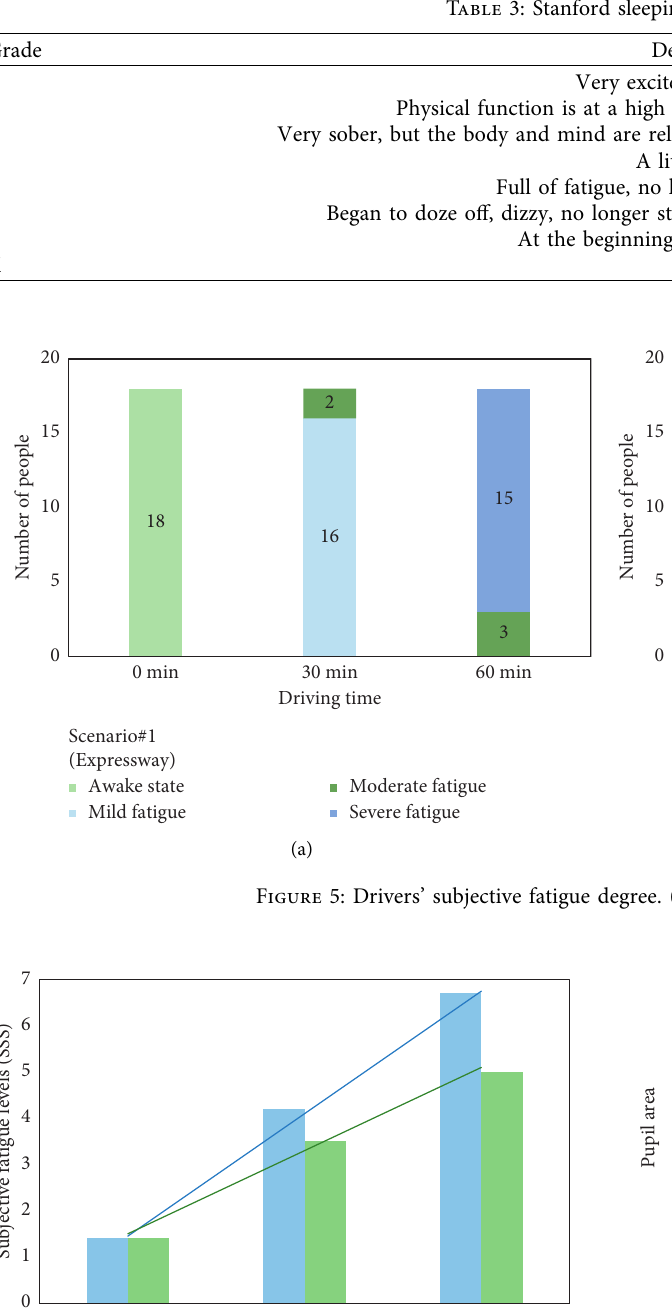
Table 3: Stanford sleepiness scale.